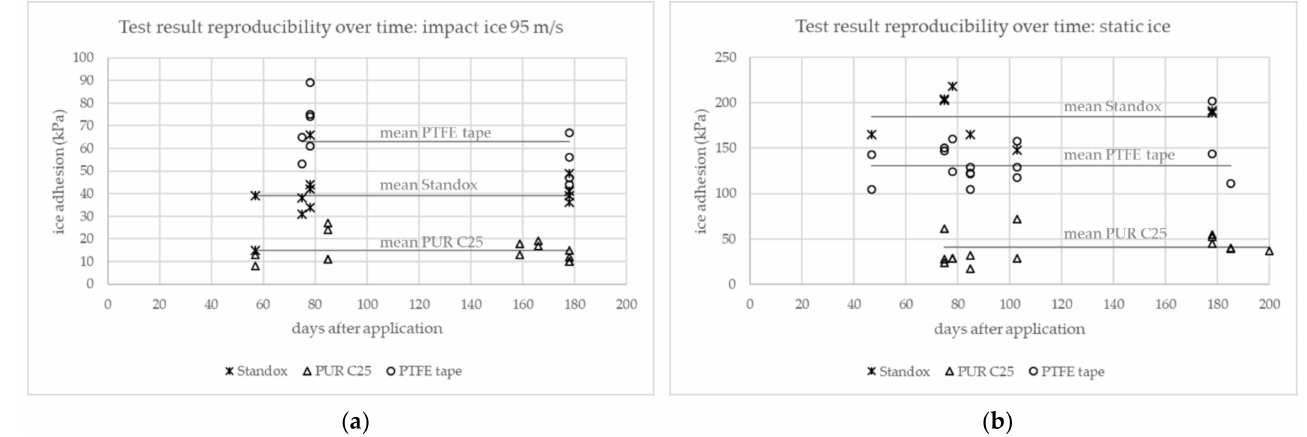
Figure 5. Test result reproducibility for ice adhesion tests over the complete test period: ( a ) for impact ice 95 m/s (200 rpm/s); ( b ) for static ice (200 rpm/s) (the given lines indicate the resulting means per